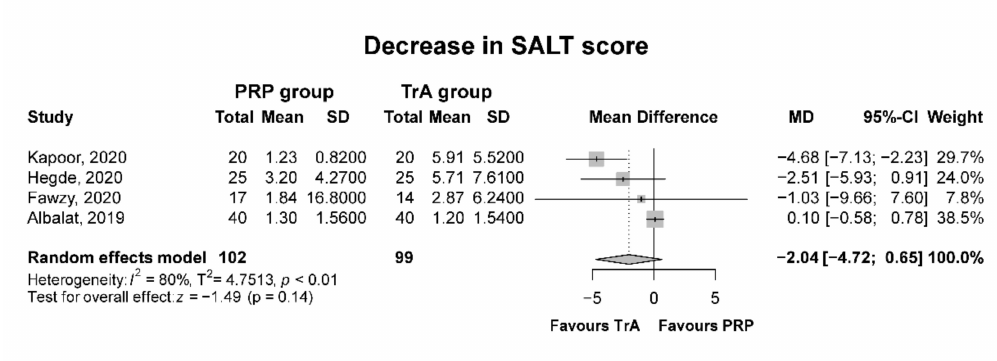
Figure 2. Forest plot for the mean decrease in the SALT score; platelet-rich plasma (PRP) compared to triamcinolone acetonide